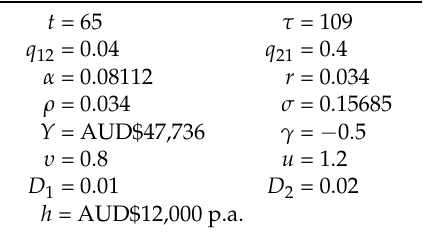
Table 1. Parameters used in the numerical